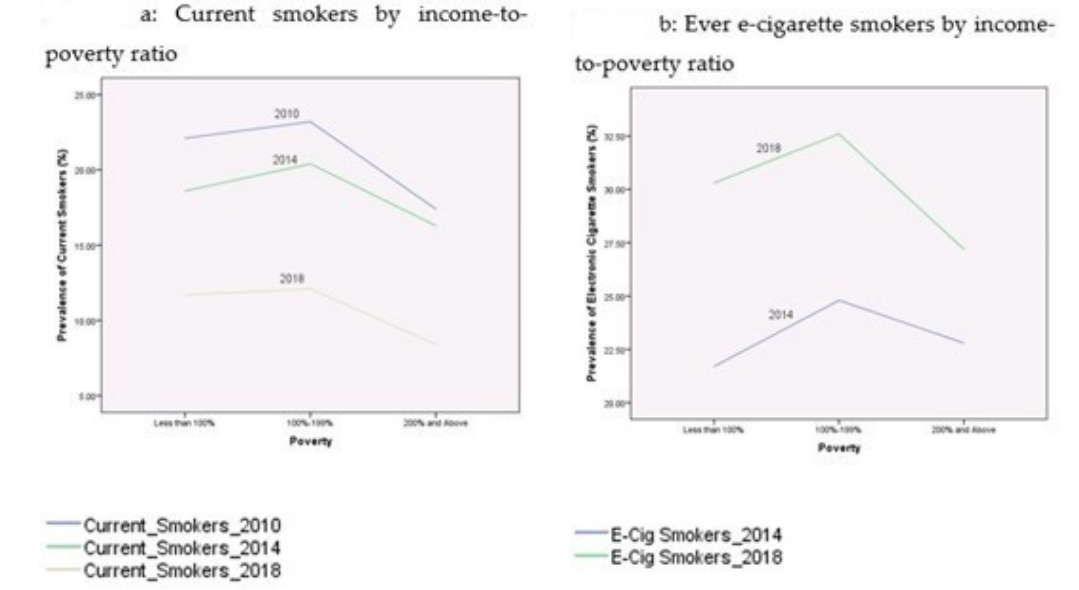
Figure 4. Prevalence of smoking behaviors by income-to-poverty ratio, NHIS 2010–2018.